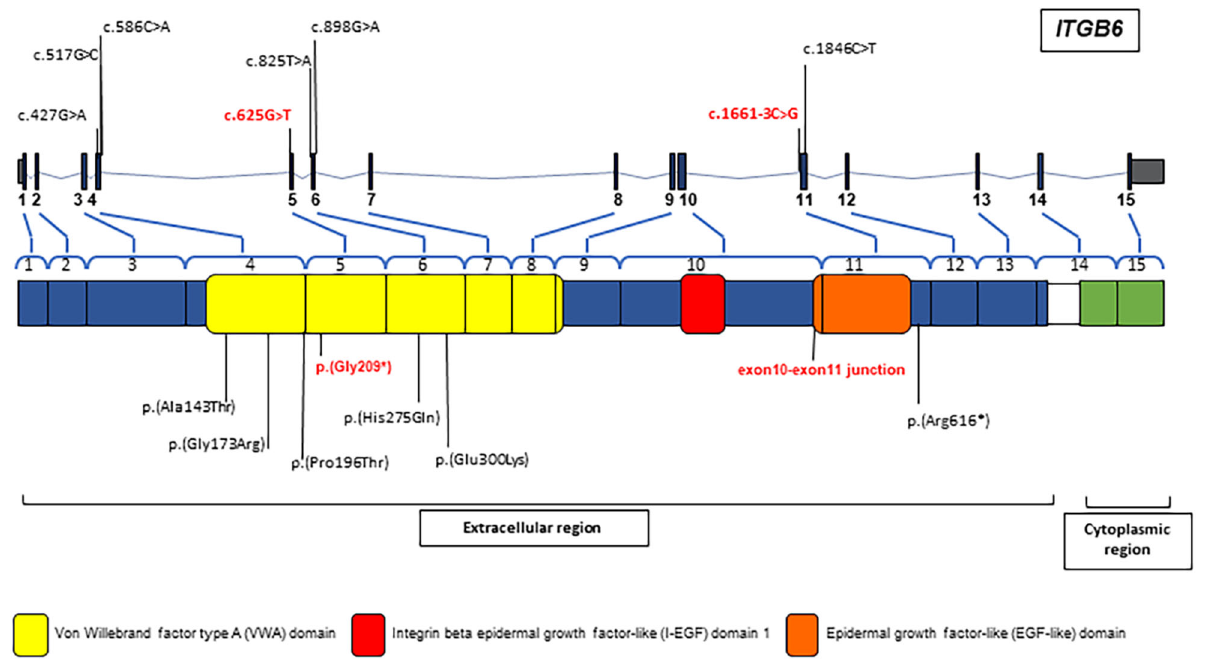
Fig. 5 Schematic diagram of the ITGB6 gene and protein. In both schemes, all ITGB6 variants identi fi ed to date, which associated with enamel malformation, are shown. The variants detected in this study are in bold